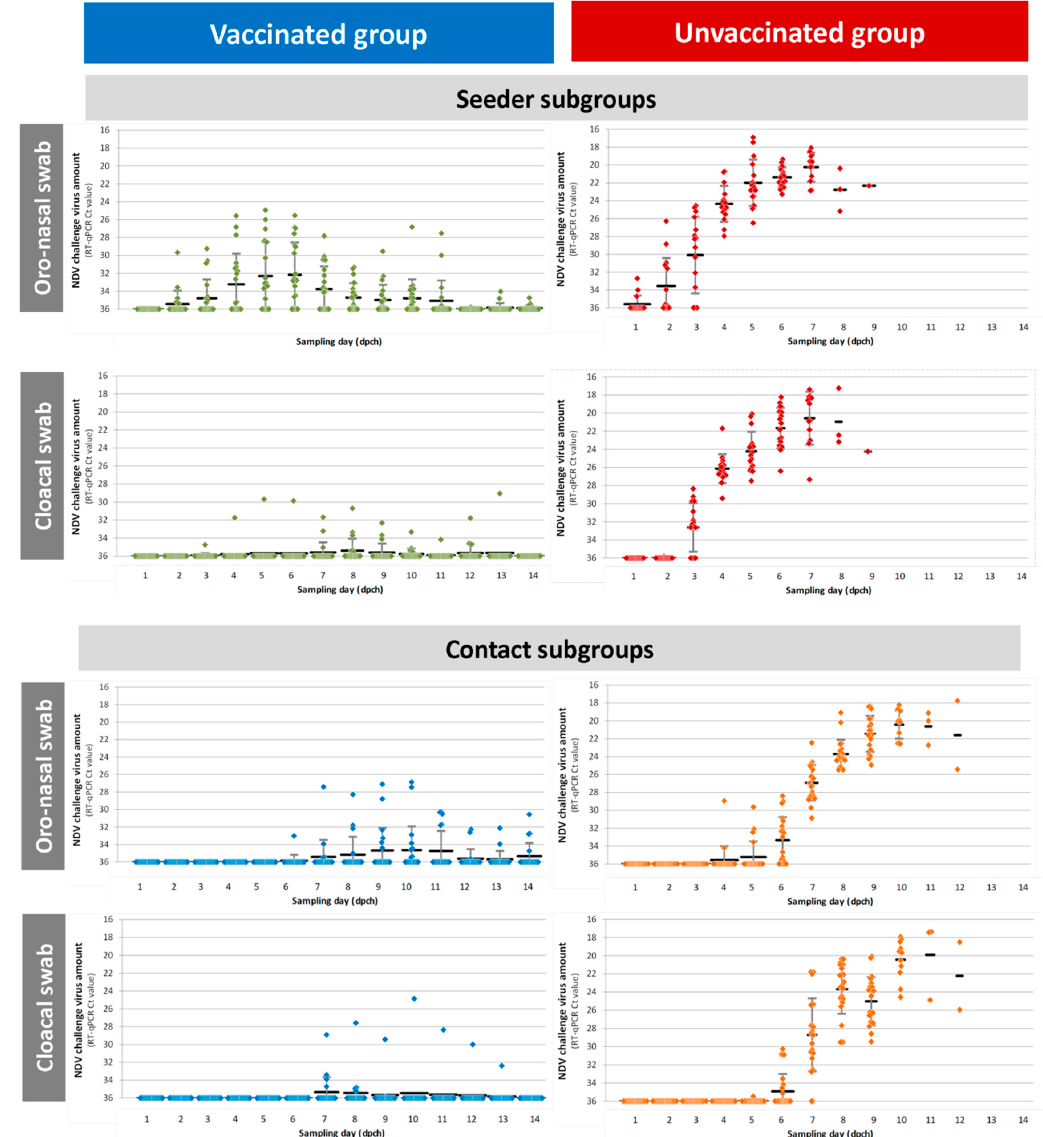
Figure 3. Kinetics of velogenic Newcastle disease virus (NDV) shedding in vaccinated and unvaccinated birds after direct infection (seeder subgroups) or contact infection (contact subgroups). Seeder subgroups were challenged with 5.0 log 10 ELD 50 of velogenic NDV intra-nasally. Contacts were co-mingled with seeders from 8 h post-challenge. Oro-nasal swabs and cloacal swabs were collected daily for 14 days post-challenge; vNDV amount was quantified by RT-qPCR. Individual results, and mean and STD of Ct values are shown.